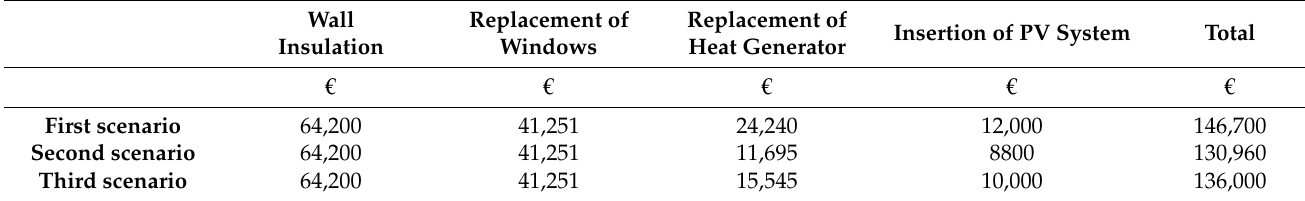
Table 9. Economic evaluation by category of